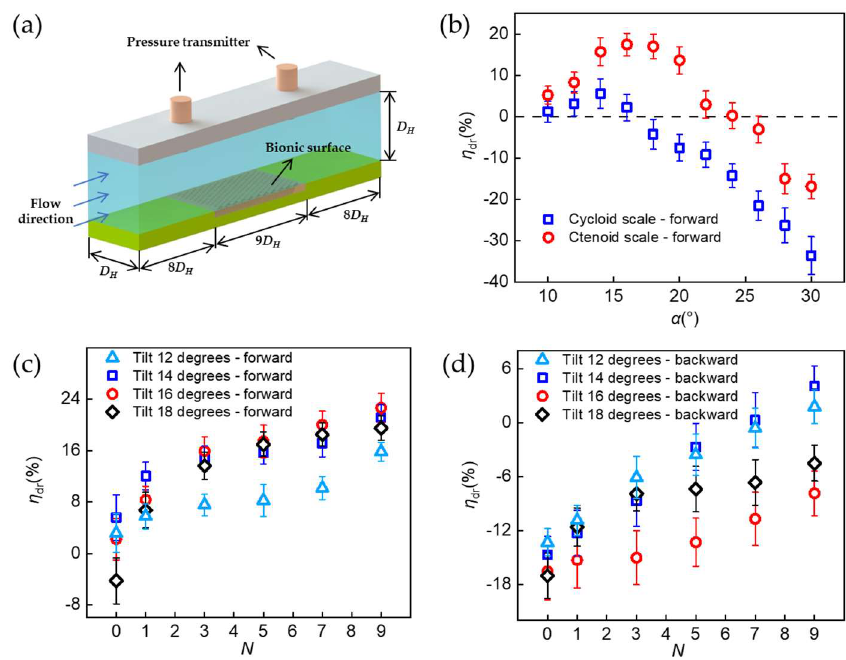
Figure 2. Drag reduction measurements. ( a ) Schematic of experimental set-up. ( b ) Forward drag reduction rates η dr of ctenoid and cycloid scales at different tilting angle α . ( c ) Forward drag reduction rates η dr at different number of spikes N . ( d ) Backward drag reduction rates η dr at different number of spikes N .